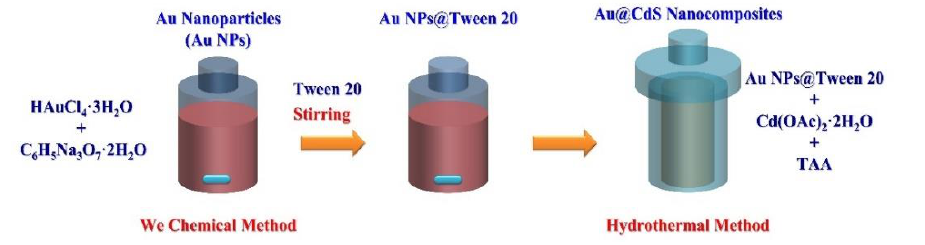
Figure 1. Schematic diagram of the fabrication processes for the growth of Au@nanocomposites. The XRD pattern (Figure 2a) of Au@CdS nanocomposites was grown at the reaction temperature of 120 °C for 3 h in the different concentrations of CdS precursors of 1, 2.5, 5, and 10 mM, respectively. The observed diffraction peaks for CdS at 24.9°, 26.7°, 28.3°, 43.9°, and 52.1° corresponded to (100), (002), (101), (110), and (112) crystal planes of the hexago- nal phase of CdS (JCPDS No. 80–0006), respectively. The observed diffraction peaks for Au at 38.2°, 44.4°, 64.6°, and 77.6° corresponded to (111), (200), (220), and (311) crystal